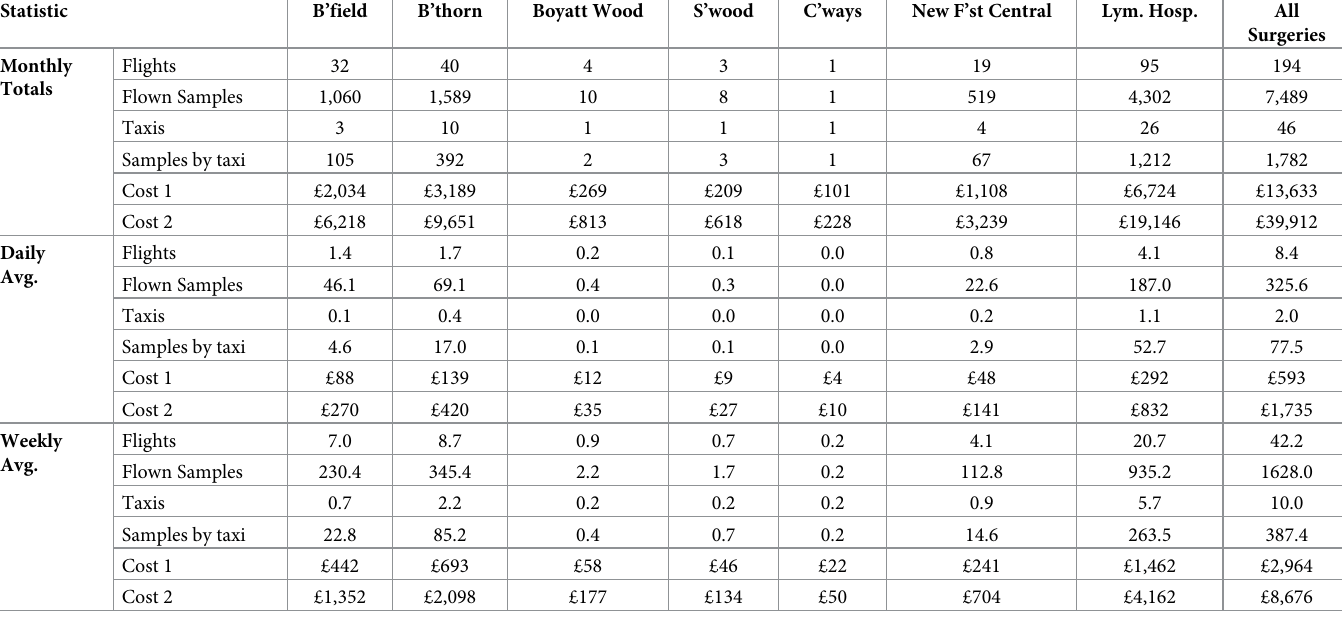
Table 1. Summary of flights, samples and costs for the UAV collection